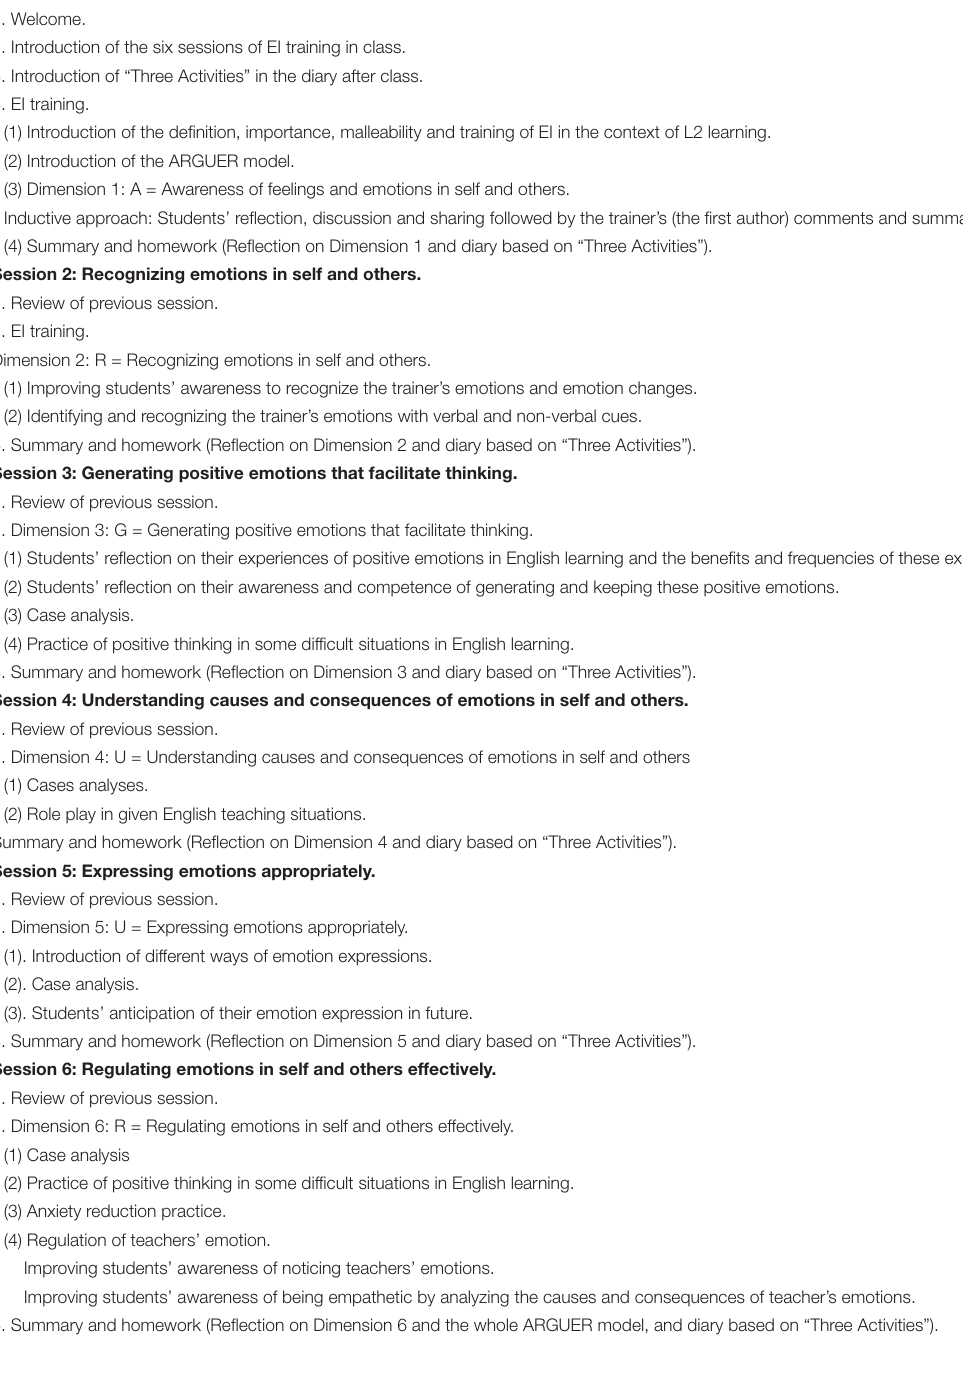
TABLE A1 | Outline of Emotional Intelligence Training Sessions. Session 1: Awareness of feelings and emotions in self and